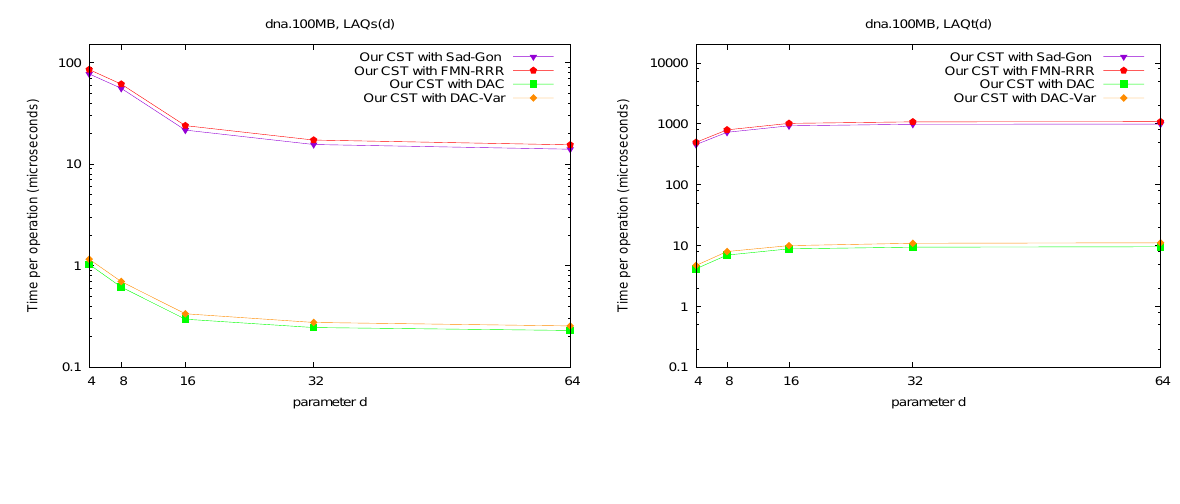
Figure 8. Space/Time trade-off performance for operation LAQ the log